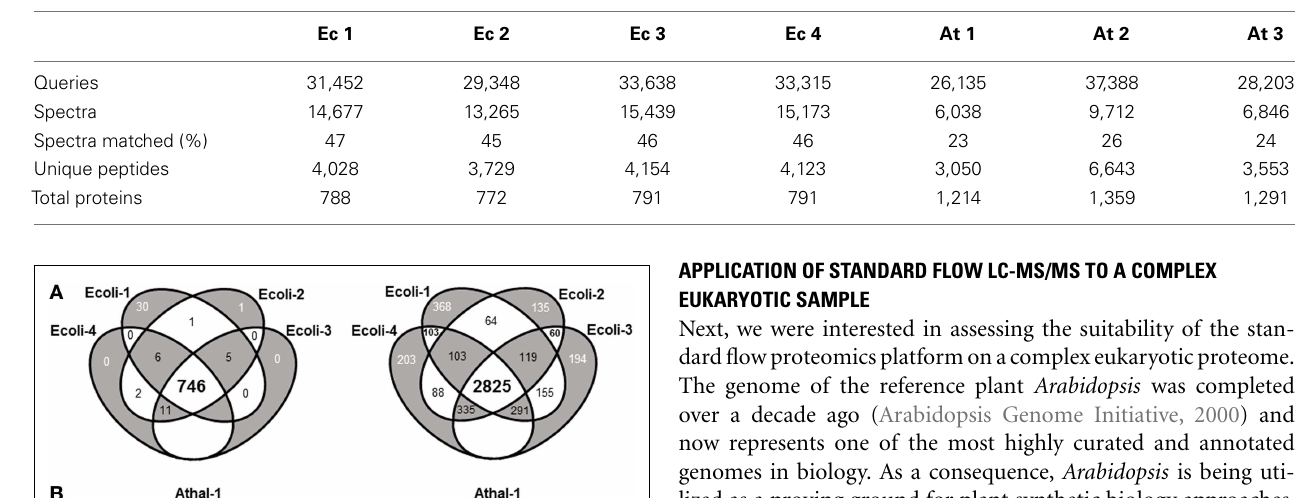
Table 1 |Values obtained from E. coli (Ec) and Arabidopsis (At) samples analyzed using the standard flow technique .